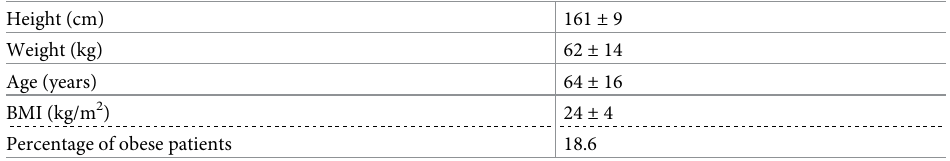
Table 1. Patient characteristics (N =